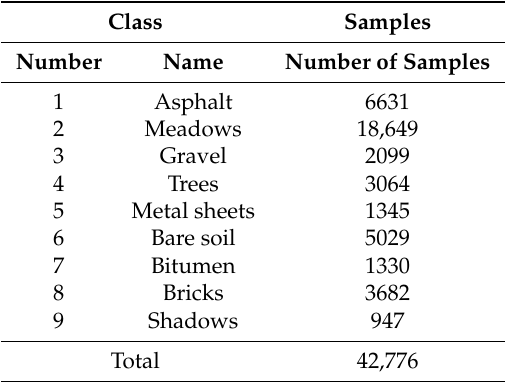
Figure 6. Color coding for the Pavia University data set. Table 3. Sample size for the Pavia University